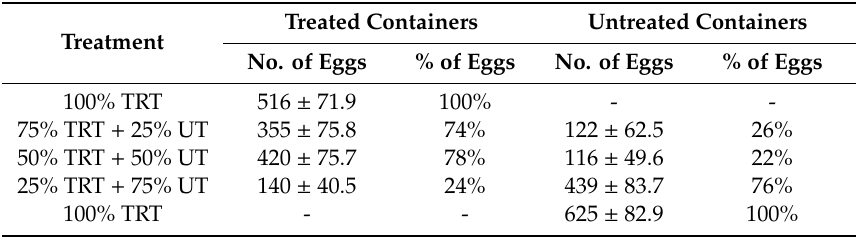
Table 1. Oviposition in pyriproxyfen-treated and untreated water containers in cages with Aedes aegyptii females. Treated Containers Untreated Containers Treatment No. of Eggs % of Eggs No. of Eggs % of Eggs 100% TRT 516 ± 71.9 100% - - 75% TRT + 25% UT 355 ± 75.8 74% 122 ± 62.5 26% 50% TRT + 50% UT 420 ± 75.7 78% 116 ± 49.6 22% 25% TRT + 75% UT 140 ± 40.5 24% 439 ± 83.7 76% 100% TRT - - 625 ± 82.9 100% TRT = treated; UT =